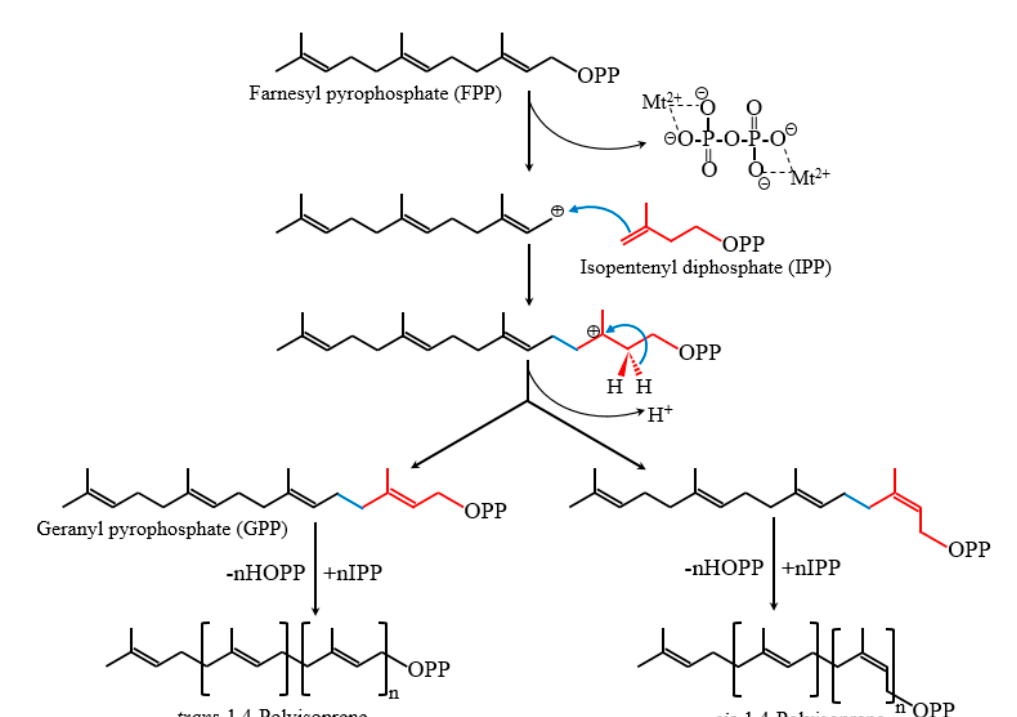
Figure 2. Proposed initiation and polymerization mechanism in rubber biosynthesis.